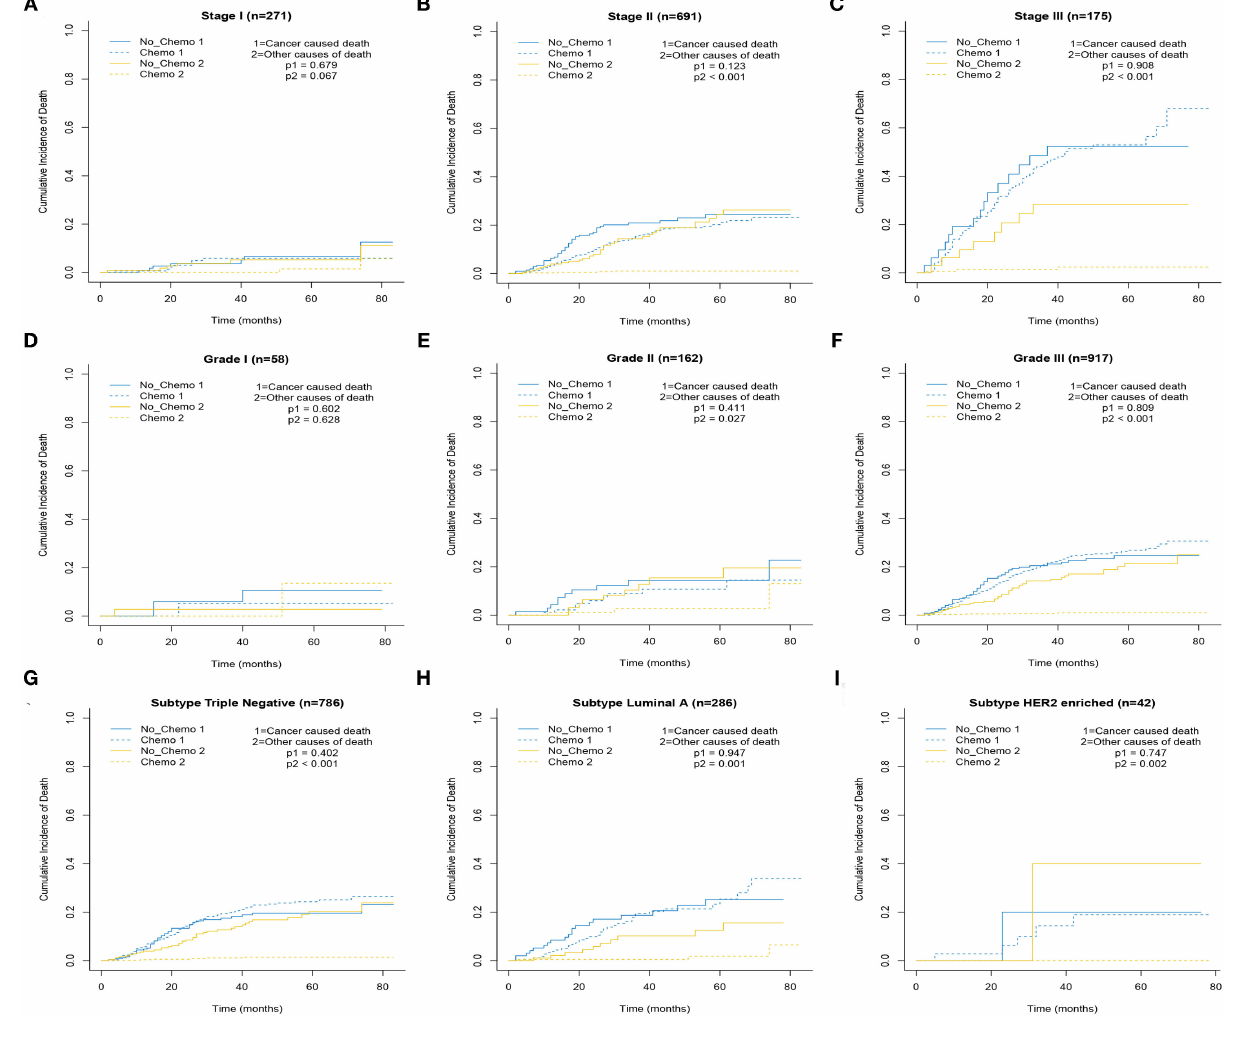
Frontiers in Oncology |